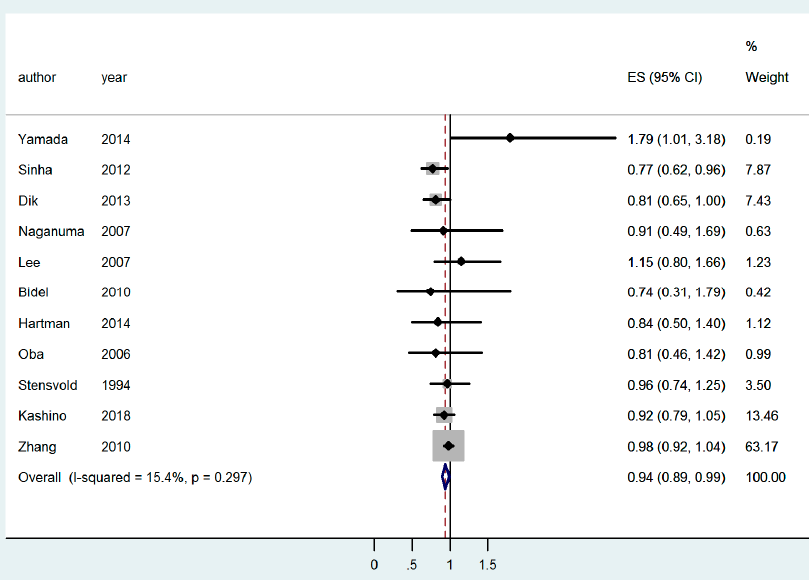
Figure 3. Forest plot of colon cancer in men.